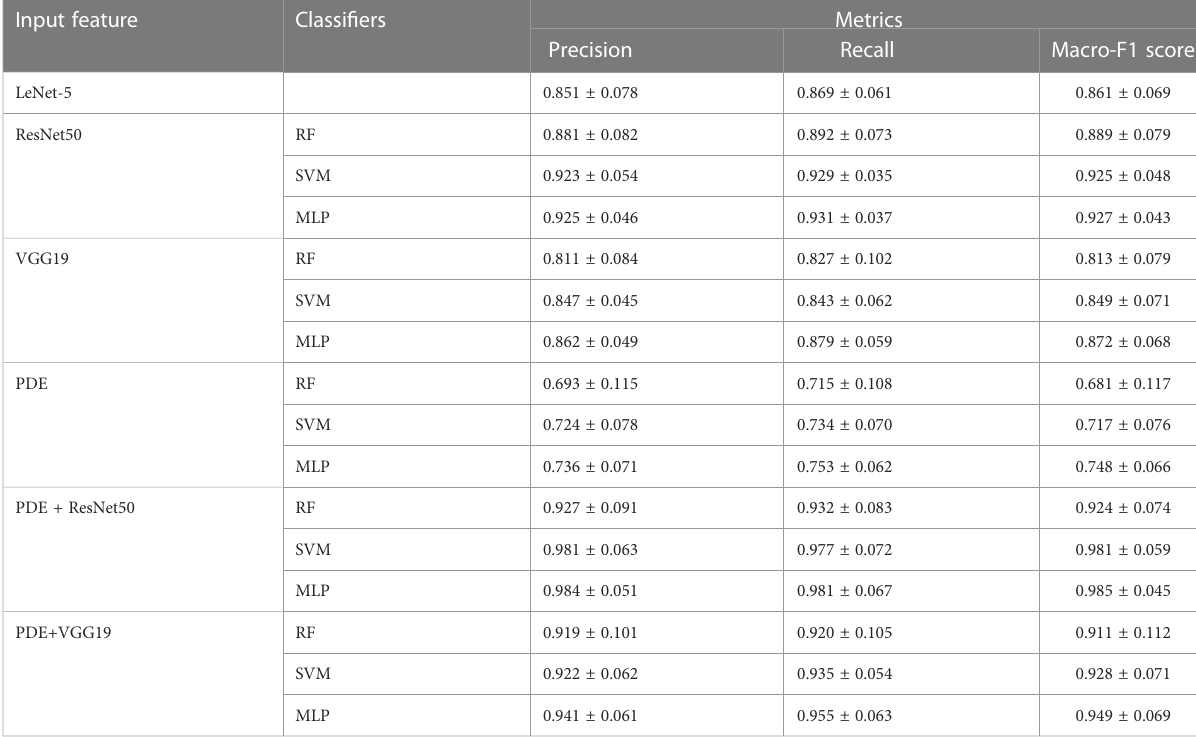
TABLE 1 Predictive accuracies obtained with different combination of features and classi fi ers by 5-fold CV. Input